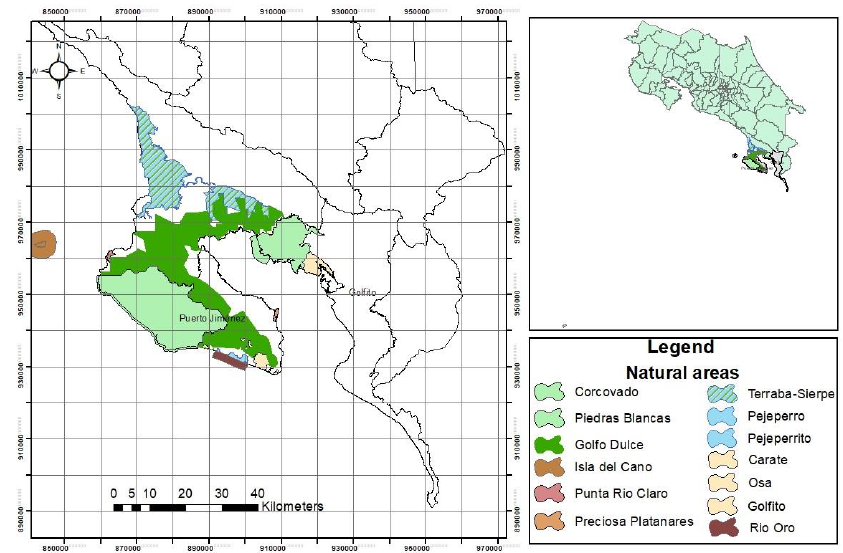
Figure 1. Natural areas around Jiménez and Golfito.